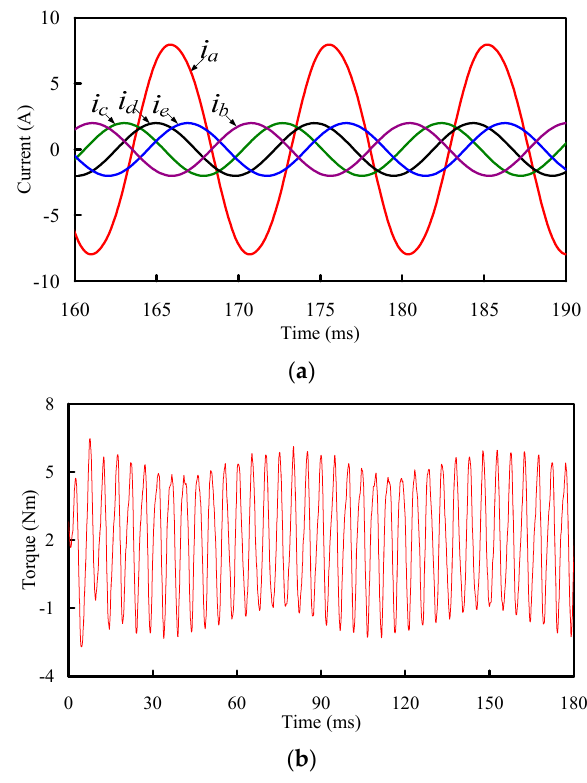
Figure 5. Performance under short ‐ circuit fault condition: ( a ) Currents; ( b ) Output torque.